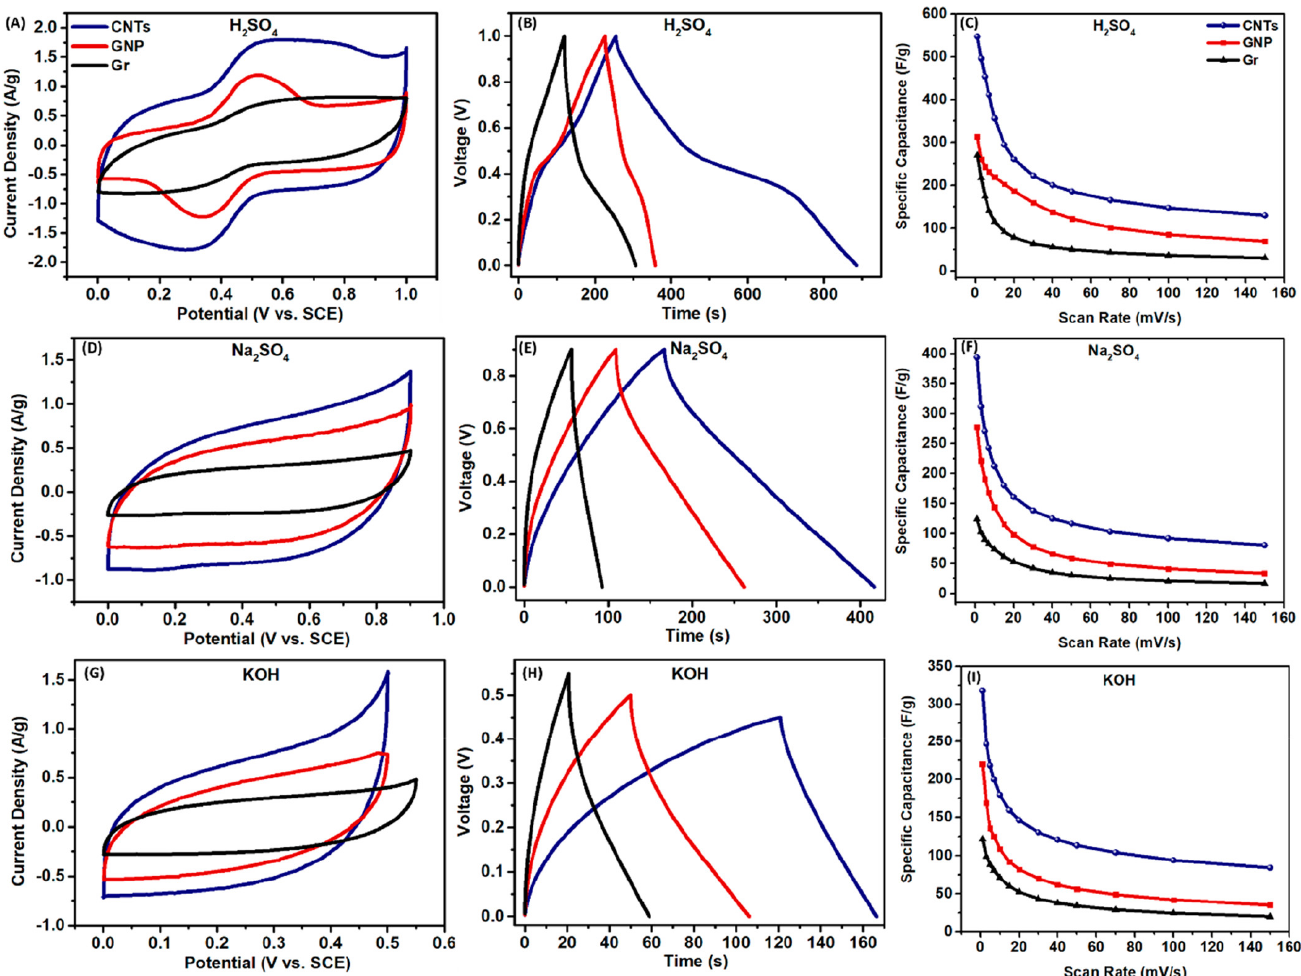
Figure 9. Performance of the carbon materials in the positive potential window in different electrolytes measured in three-electrode configuration: (in H 2 SO 4 electrolyte) ( A ) CVS of carbon materials at 5 mV s − 1 , ( B ) GCDs of carbon materials at 0.7 A g − 1 , ( C ) rate capability of the carbon materials; (in Na 2 SO 4 electrolyte) ( D ) CVS of carbon materials at 5 mV s − 1 , ( E ) GCDs of carbon materials at 0.7 A g − 1 , ( F ) rate capability of the carbon materials; (in KOH electrolyte) ( G ) CVS of carbon materials at 5 mV s − 1 , ( H ) GCDs of carbon materials at 0.7 A g − 1 , ( I ) rate capability of the carbon materials. Reprinted with permission from Ref. [21]. 2021,